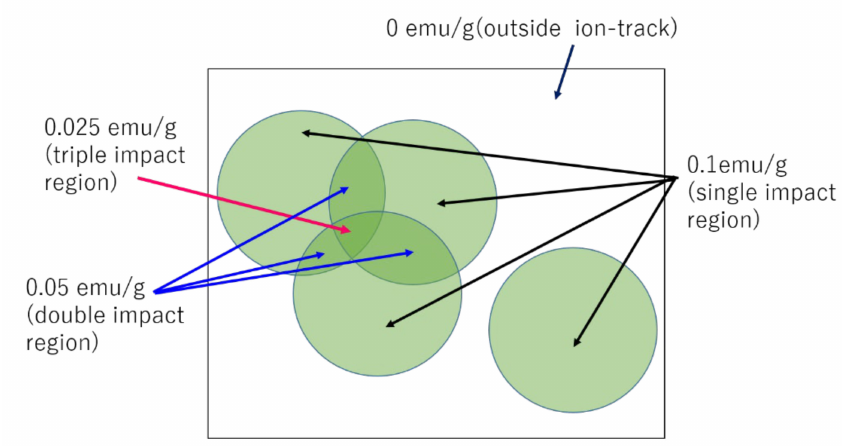
Figure 10. Schematic drawing of the e ff ect of ion-track overlapping on the irradiation-induced saturation